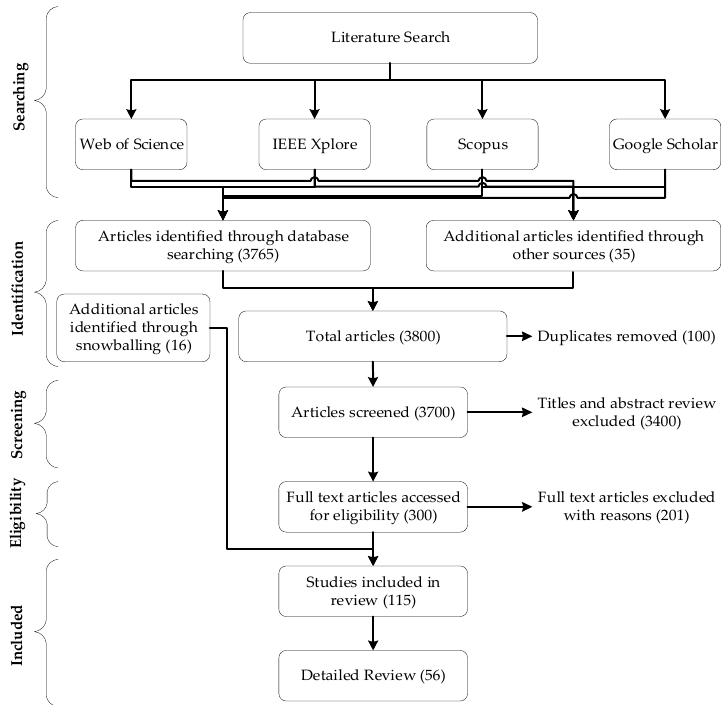
Figure 1. The flow diagram of the articles for the literature review.